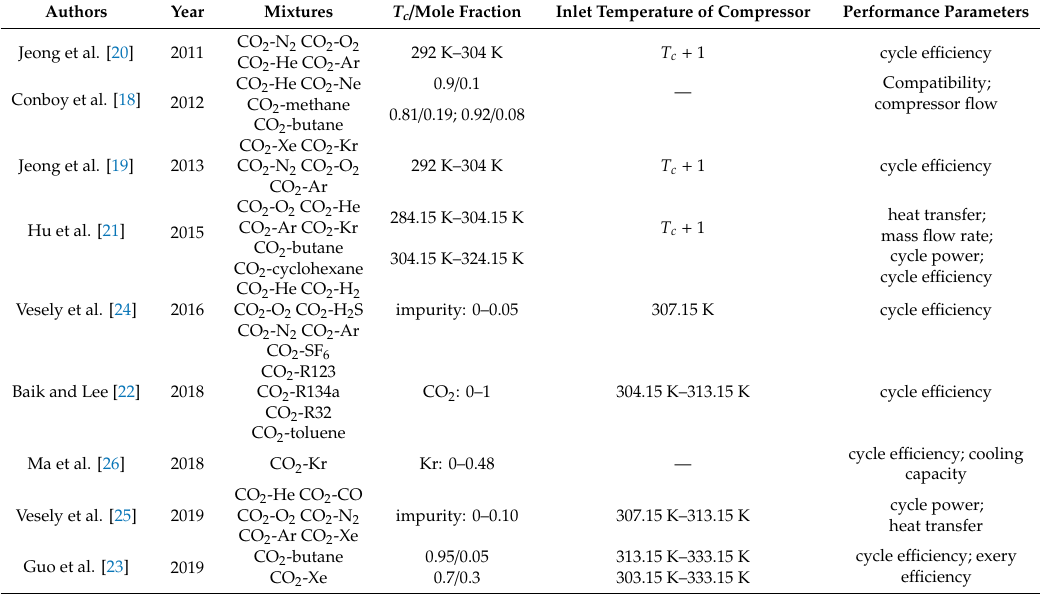
Table 1. Research summary on the Brayton cycle with CO 2 -based